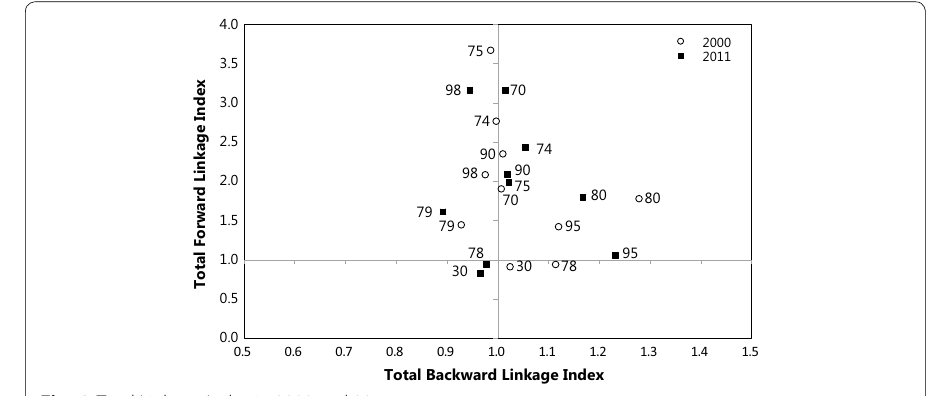
Fig. 6 Total Linkage Index in 2000 and